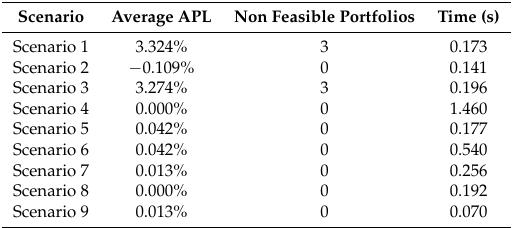
Table 9. Different scenarios based on Instance 1 (Hang